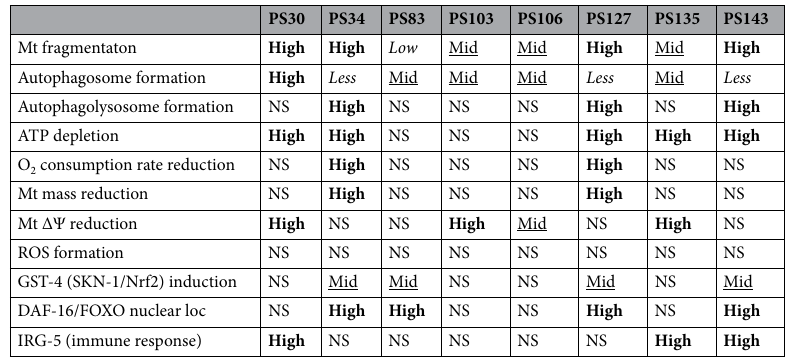
Table 1. Summary of PS compounds’ effects on various mitochondrial parameters and other cellular pathways. NS not significant.